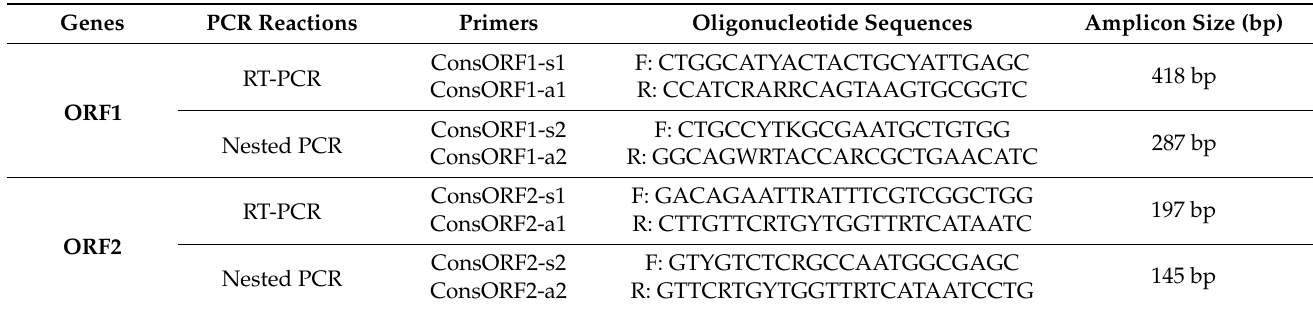
Table 2. Target genes used for HEV RNA detection, as reported by Wang et al.